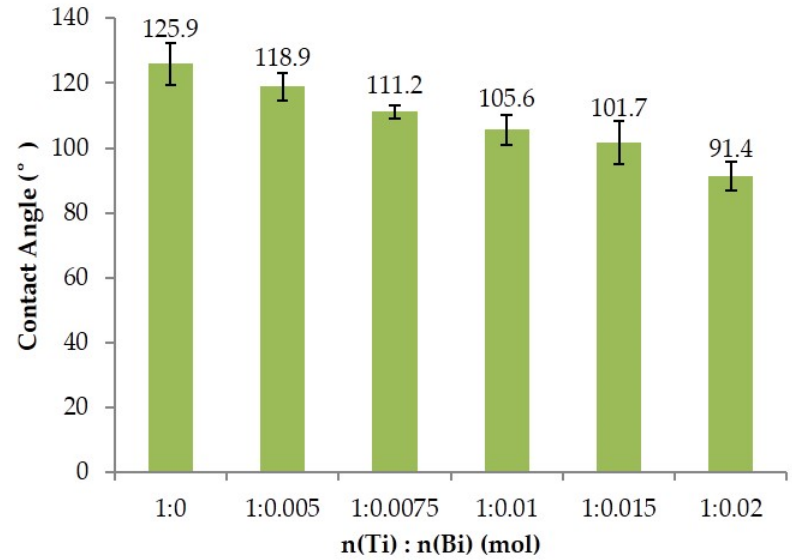
Figure 13. The contact angle of Si–Ti composite film prepared at different Bi-doped amounts.